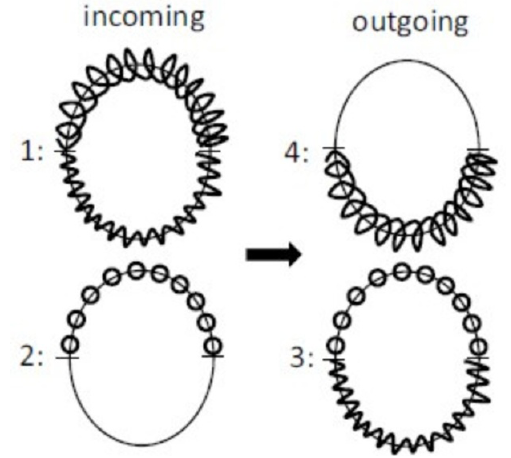
Figure 19 . These (cid:12)gures illustrates how we think of the four cyclically ordered chains corresponding to the two incoming, 1 and 2, and the two outgoing, 3 and 4, strings in the scattering process, are divided into pieces according to where they are going or coming from. That is to say we denoted by one signature that series of objects on the cyclically ordered chain corresponding to string 1 which go into the cyclically ordered chain corresponding to the outgoing string 4, say. Similarly the other pieces going to or coming from a speci(cid:12)c cyclically ordered chain and going to a speci(cid:12)c other one have got a distinguishable signature. The arrow symbolizes the transition from initial to (cid:12)nal